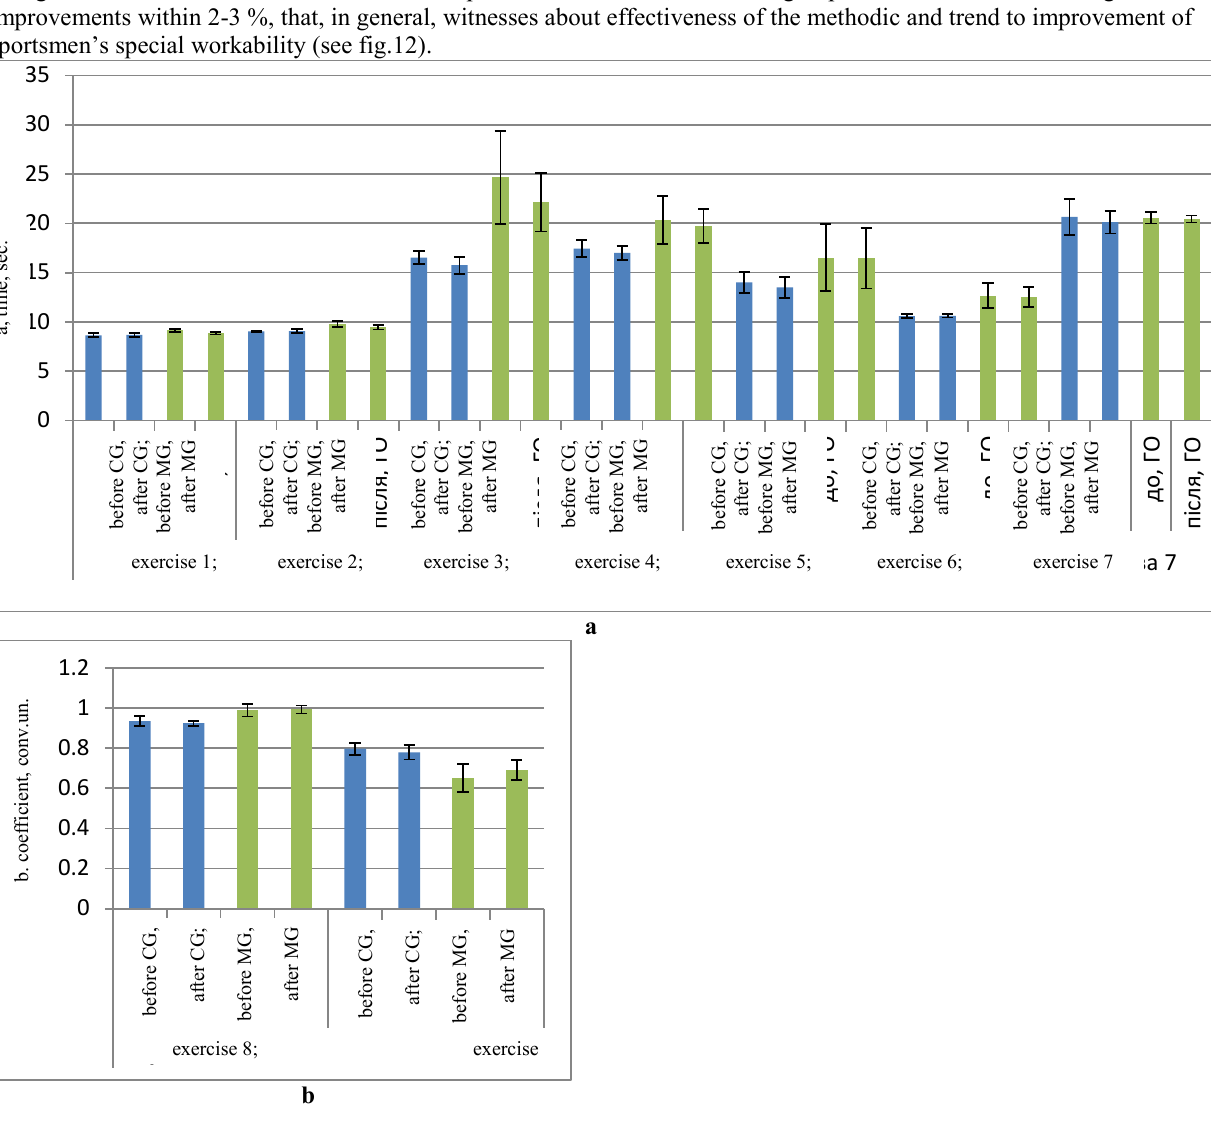
Fig.12. Indicators of control testing before and after experiment in main group (MG) and comparative group (CG), mixed cluster: a) a-lactate orientation; b) “lactate” orientation. (р ≤0.001). CG – comparative group; MG – main